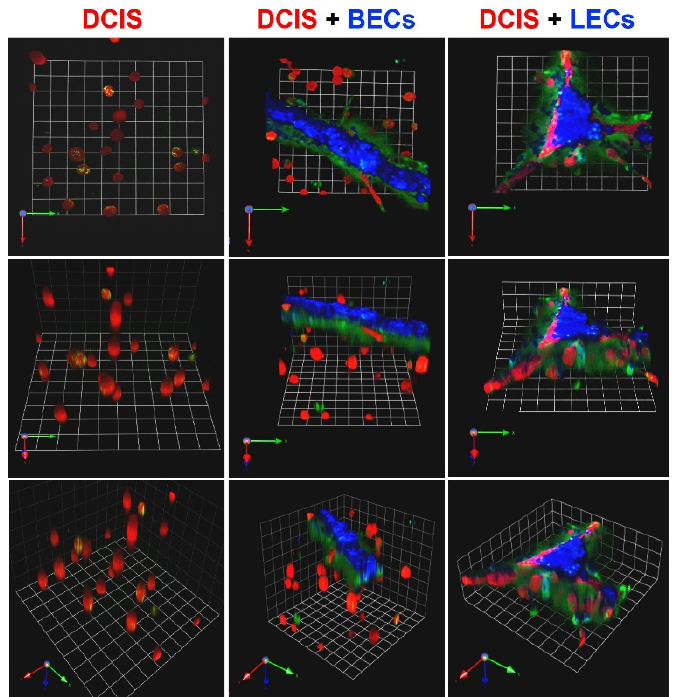
Figure 1. Ductal carcinoma in situ (DCIS) spheroids preferentially associate with microvascular lymphatic endothelial cell (LECs) networks. In 3D rBM overlay cultures, TN pre-invasive MCF10.DCIS cells form spheroidal structures; primary BECs form tubular structures; and primary LECs form triangular prism-like structures. Representative images of 3D reconstructions are shown en face and angled to illustrate the 3D structures formed by MCF10.DCIS-lenti-RFP (DCIS, red) cells alone ( left ) or in coculture with blood vessel microvascular endothelial cells (BECs, blue; middle ) or LECs (blue; right ). The rBM is mixed with DQ-collagen IV and green fluorescence represents degradation products of collagen IV. Cultures were imaged live at day 2; each grid represents 45 μ m.